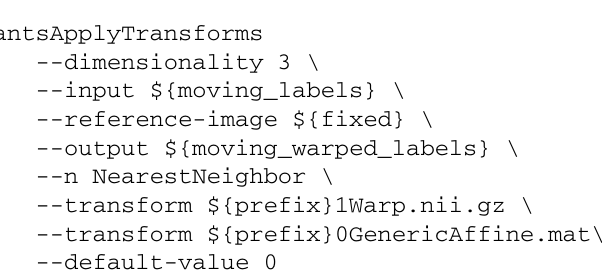
Table 1 | Brief overview of the data sets used for the SyN vs. B-spline SyN comparison.